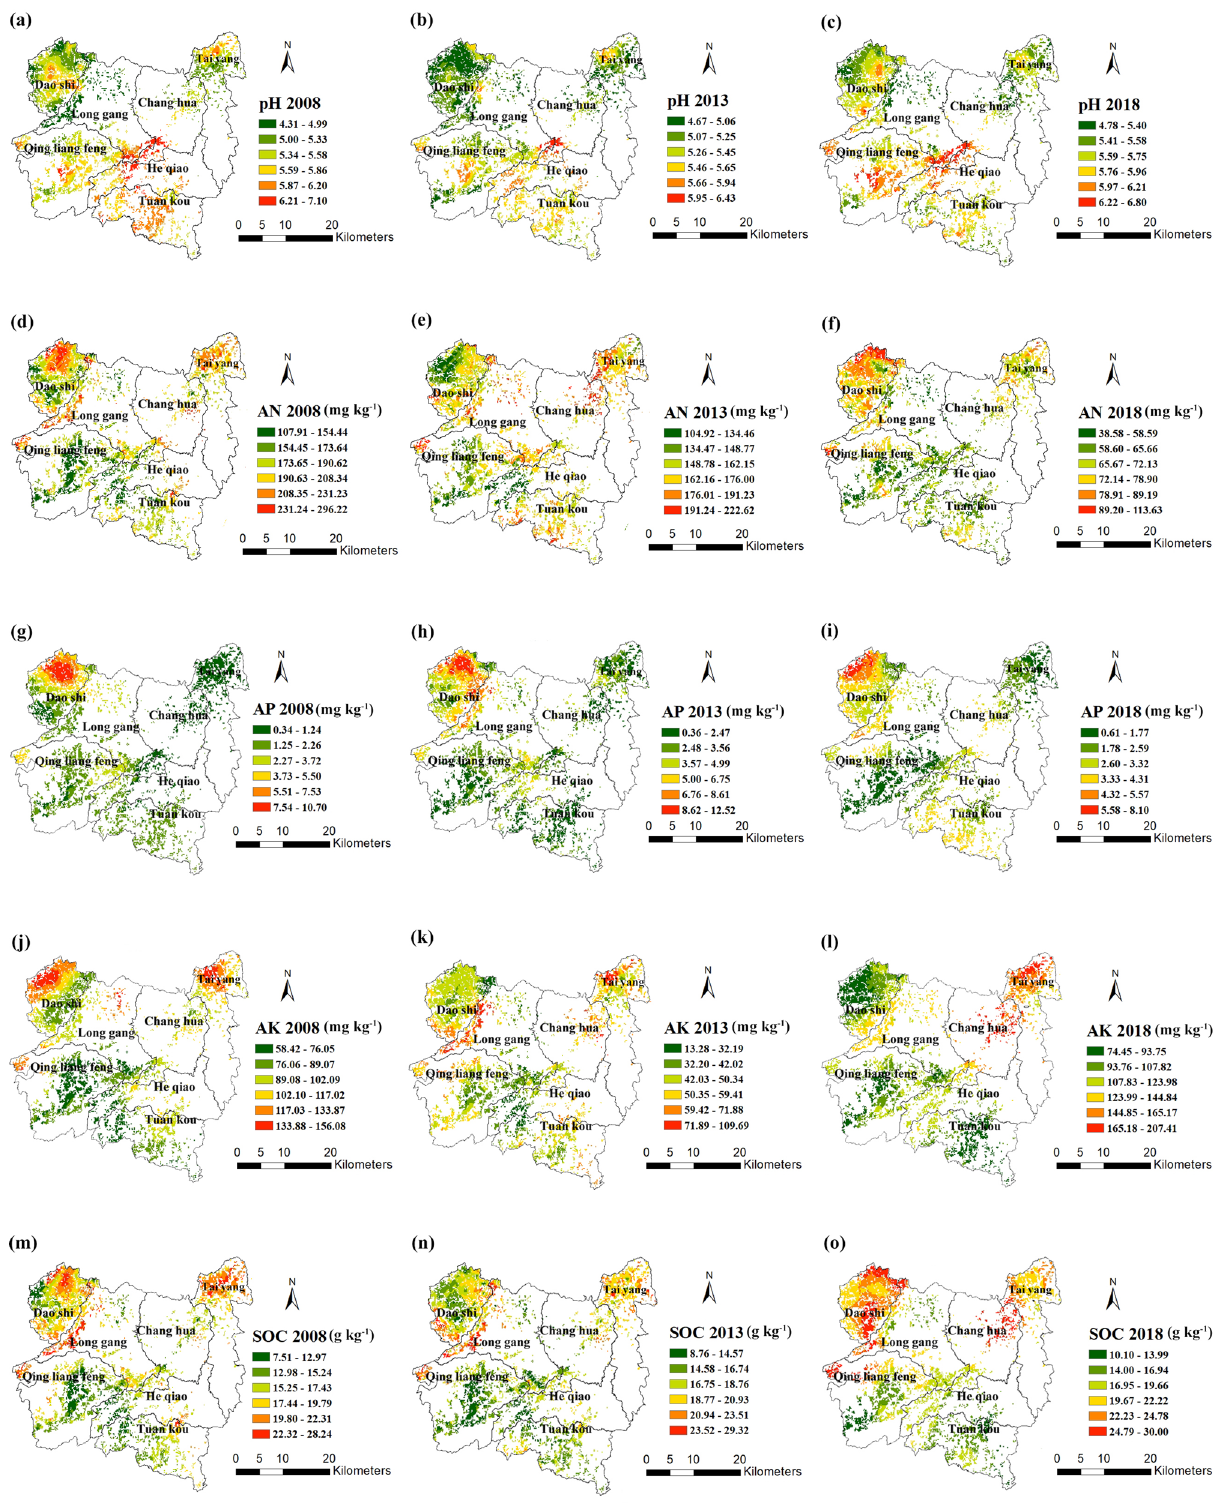
Figure 3. Spatial distribution maps of soil properties in Chinese hickory plantation regions. AN available nitrogen, AP available phosphorus, AK available potassium, SOC soil organic carbon. The maps were created in ArcGIS desktop